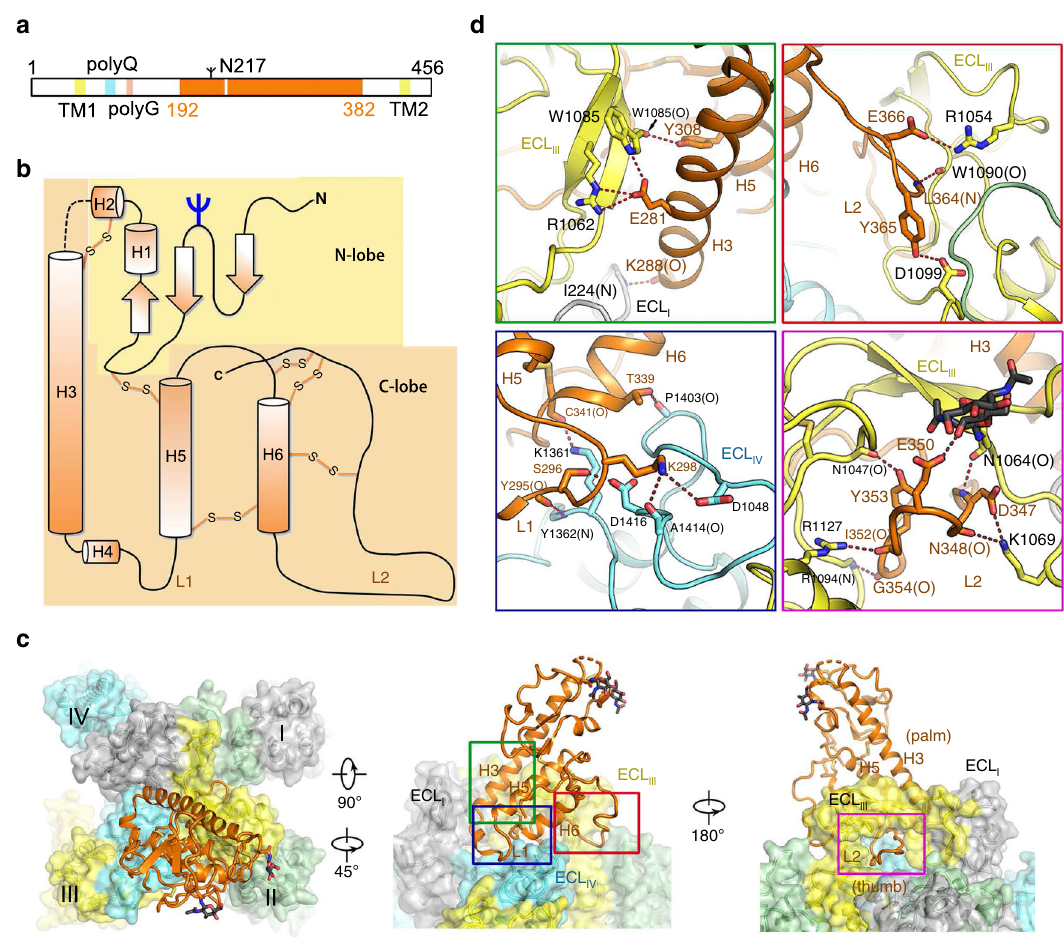
Fig. 3 Speci fi c interactions between NALCN and FAM155A. a One-dimensional (1D) schematic view of FAM155A. The region that was resolved in the current structure is colored orange. The position of the glycosylation site and predicted two transmembrane helices, polyQ, and polyG motifs, are labeled. b 2D topological structure of FAM155A. c Interaction interface between NALCN and FAM155A. NALCN is shown in surface and FAM155A is shown in cartoons. Details in the rectangle boxes are presented in d . d Zoom in views of each interaction interface. The electrostatic interactions are indicated by red dashed lines. The residues from NALCN and FAM155A are labeled black and orange, respectively. Please also refer to Supplementary Table 2 for a summary of the interactions between NALCN and